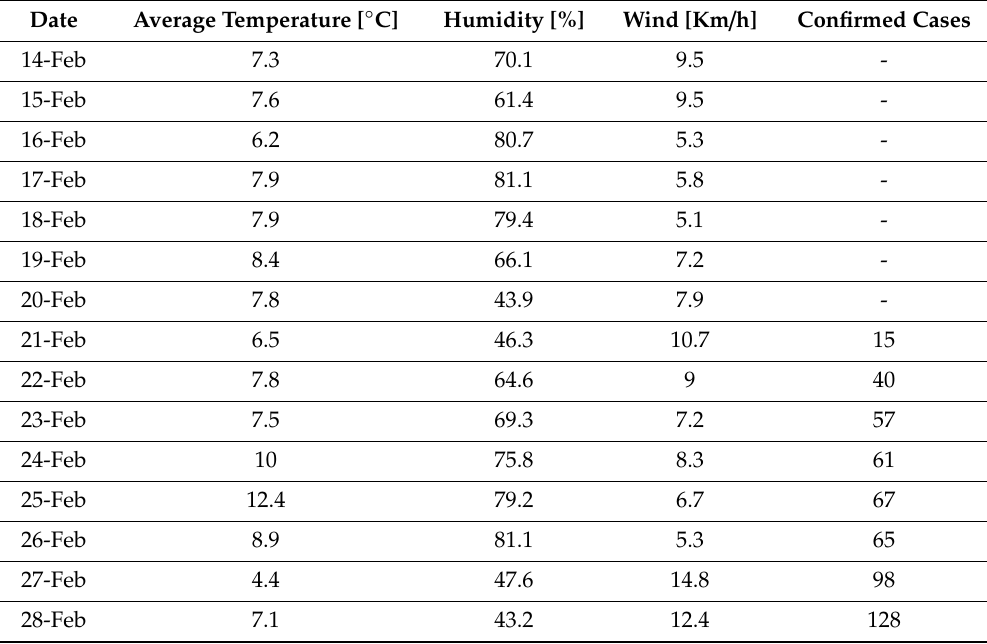
Table A1. The dataset of Lombardy (Milan),